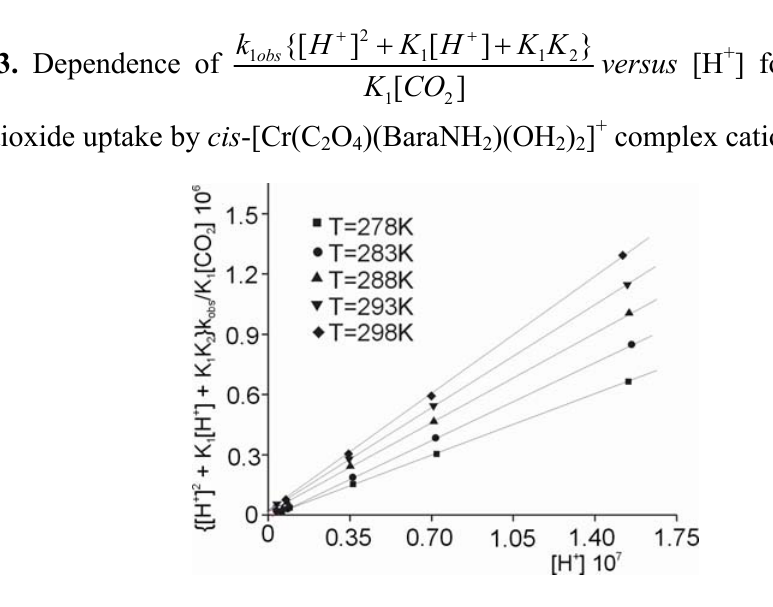
, k ) and acidity constants (K 1 2 4